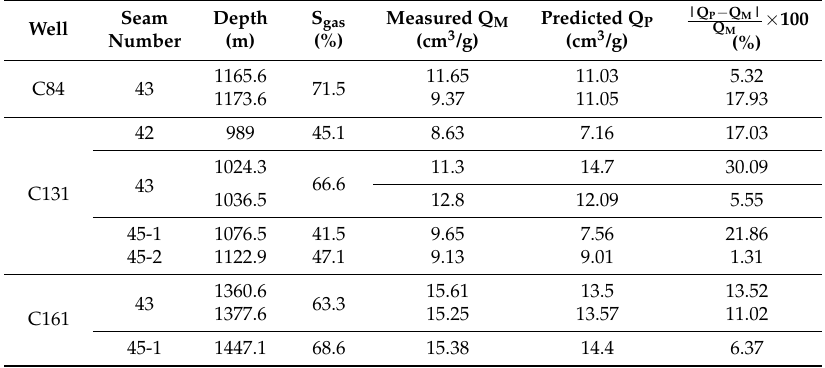
Table 2. The comparative results and error analysis between measured gas content and predicted gas content with Langmuir